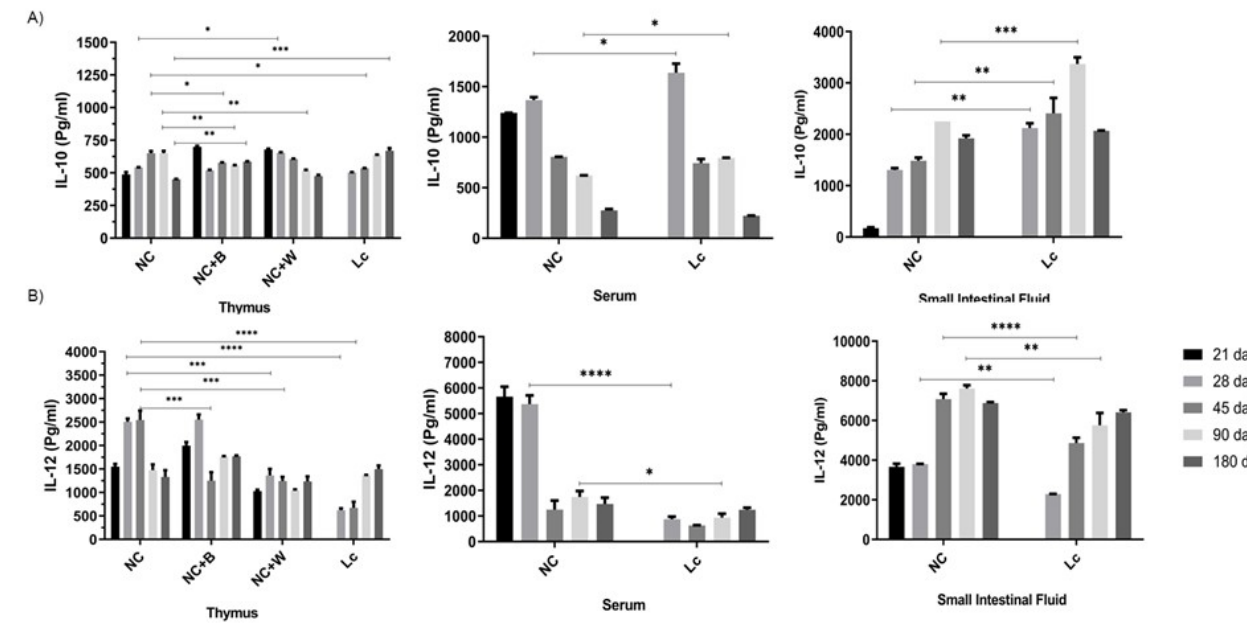
Figure 7. IL-10 and IL-12 production in the senescence animal model. Levels of: ( A ) IL-10 and ( B ) IL-12 were determined in the thymus, serum and small intestinal fluid from mice at different ages (21, 28, 45, 90 and 180 days) . Thymocytes were in vitro stimulated with the probiotic bacterium (B) or the probiotic cell wall (W), and the cytokines (IL-10 and IL-12) were determined in the supernatant after 24 h of incubation. Data were shown as mean ± SD of 3 independent experiments with 3 mice per group. One-way ANOVA with Tukey’s correction for multiple comparisons * p < 0.05; ** p < 0.01; *** p < 0.001; **** p < 0.0001.